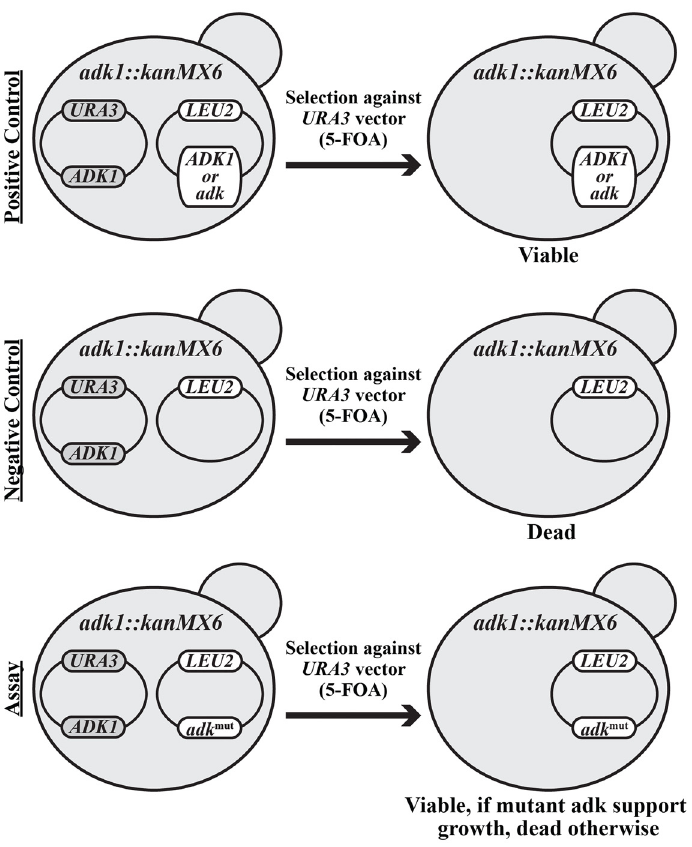
Fig 6. Yeast plasmid shuffling assay system. The yeast ADK1 open reading frame was exchanged with the KanMX cassette. Viability of the resulting strain depends on the presence of a wild-type yeast ADK1 gene in a low-copy number URA3 -based vector, pRS316. A second low-copy number LEU2 -based vector was used to introduce different alleles of the E . coli adk gene into this strain. Thus, a strain harboring both the URA3 plasmid (wild-type yeast ADK1 gene) and the LEU2 plasmid (mutated E . coli adk gene) can be obtained. If such a strain is plated on medium containing 5-FOA, the URA3 vector will be counter-selected as the URA3 gene product converts 5-FOA to a toxic compound [22]. Thus, this plasmid shuffling procedure can reveal the phenotype conferred by a mutated E . coli adk gene located in the LEU2